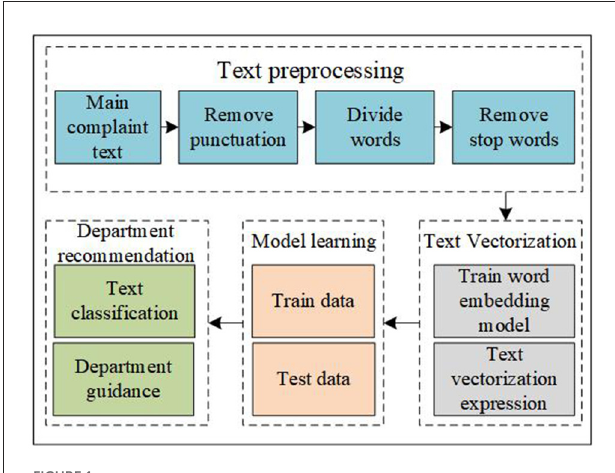
FIGURE1 The process flow of intelligent department